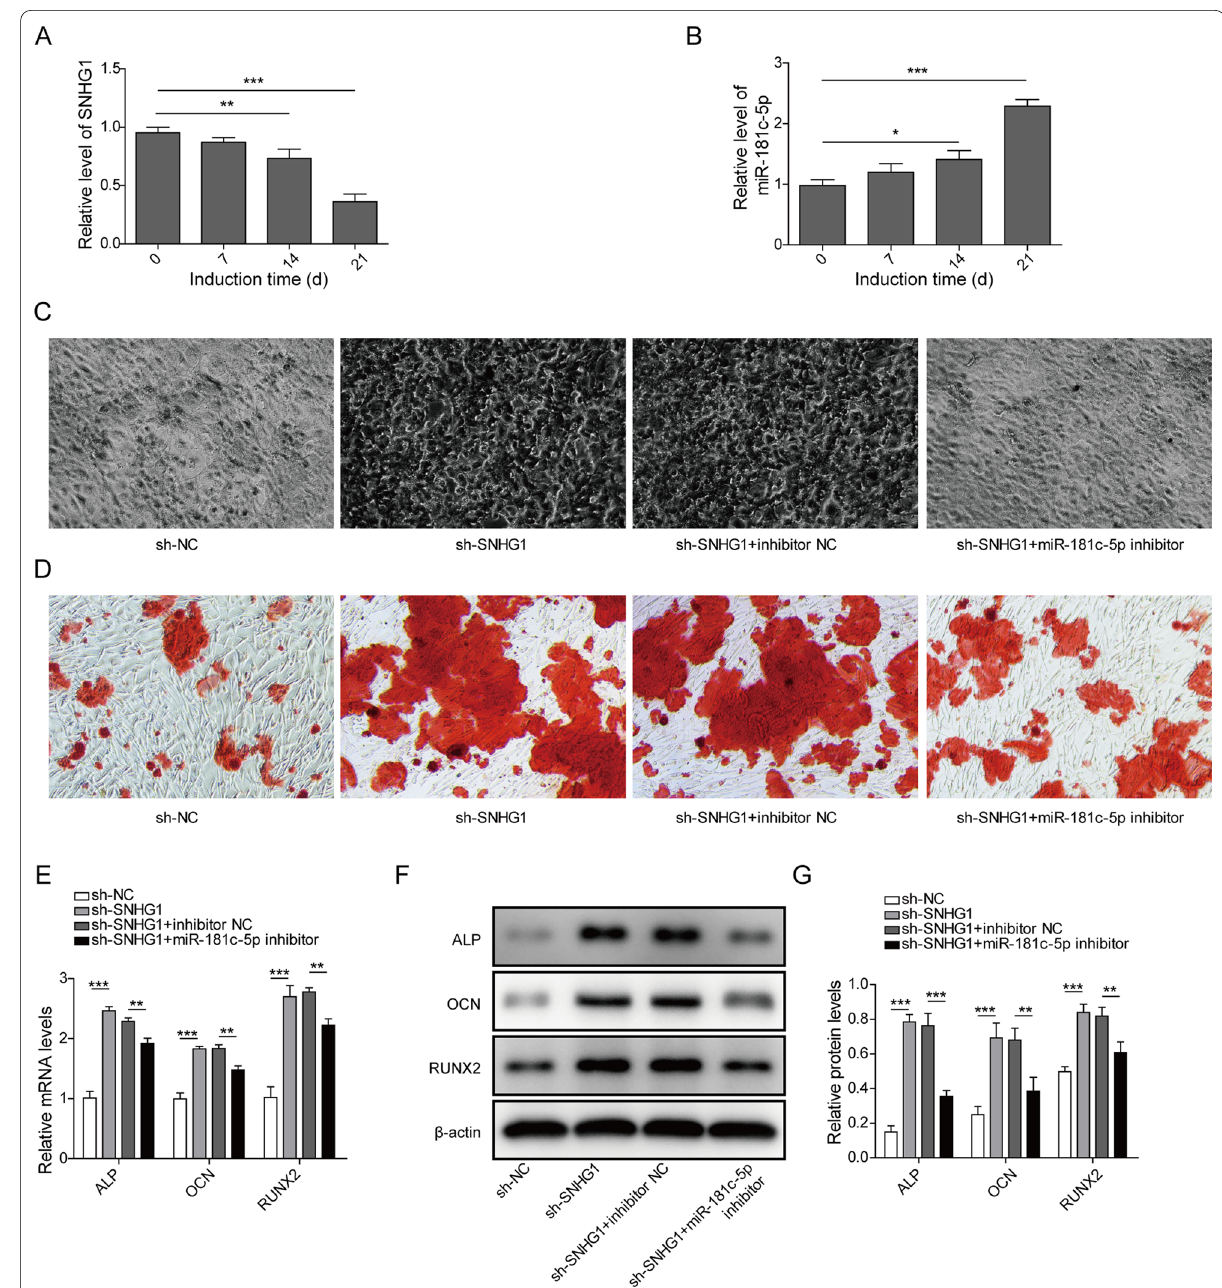
Fig. 3 LncRNA SNHG1 knockdown promoted the osteogenic differentiation of BMSCs through regulation of miR‑181c‑5p. A and B The levels of lncRNA SNHG1 and miR‑181c‑5p in BMSCs were determined using qPCR at 0, 7, 14 and 21 days after osteogenic induction. BMSCs were transfected with sh‑NC, sh‑SNHG1, sh‑SNHG1 with inhibitor NC, or sh‑SNHG1 with miR‑181c‑5p inhibitor and induced for osteogenic differentiation. C and D ALP staining and ARS were performed at day 14 and 21 after osteogenic differentiation. E–F 21 days after osteogenic induction, the mRNA and protein levels of ALP, OCN and RUNX2 in BMSCs were detected by qPCR and western blot. * P < 0.05, ** P < 0.01, *** P <